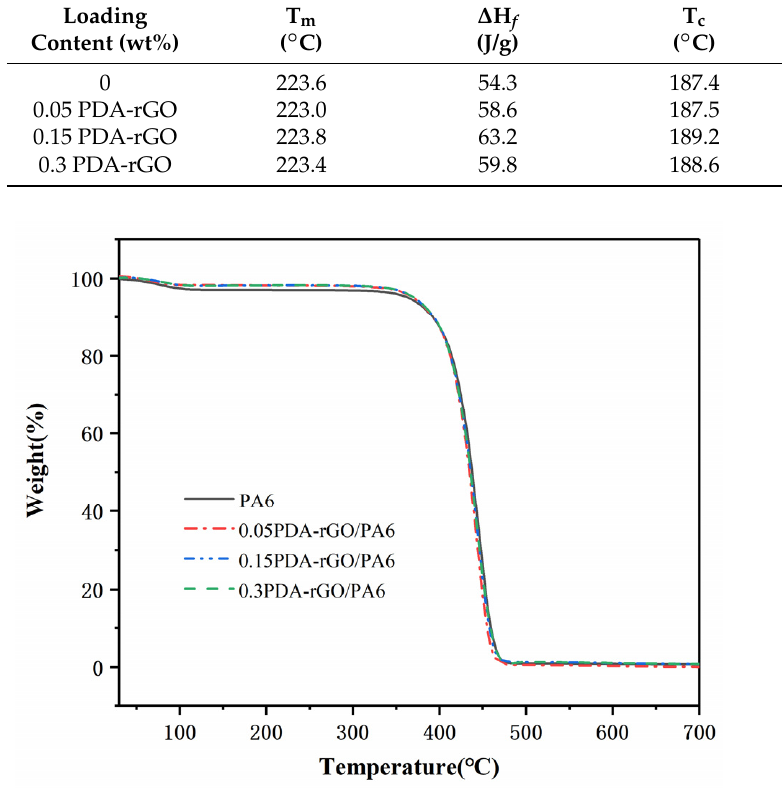
Figure 11. TGA curves of PDA-rGO/PA6 composite fibers with different PDA-rGO content. Table 3. TGA data of PA6 fiber and composite fibers containing different PDA-rGO content.